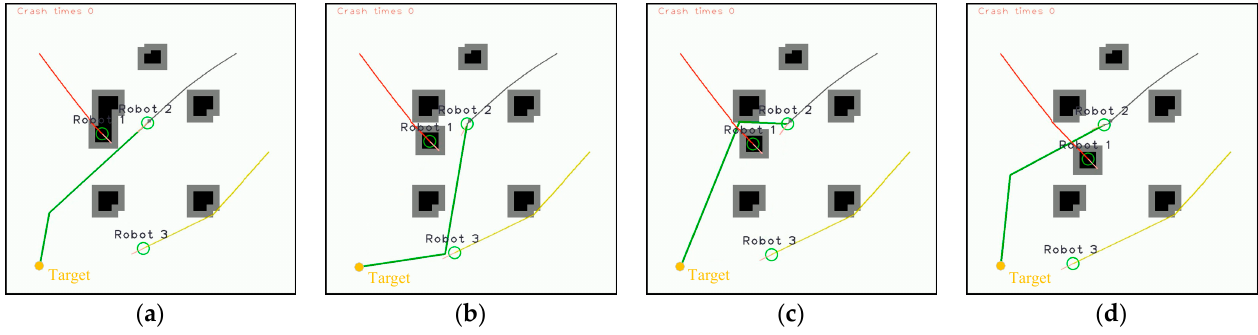
Figure 9. ( a ) The first trajectory (red line) of robot-1 arrives at the target point; ( b ) the first trajectory (gray line) of robot-2 arrives at the target point; ( c ) the first trajectory (yellow line) of robot-3 arrives at the target point; ( d ) the trajectories of all robots running between the starting point and the target point more than 50 times, respectively.